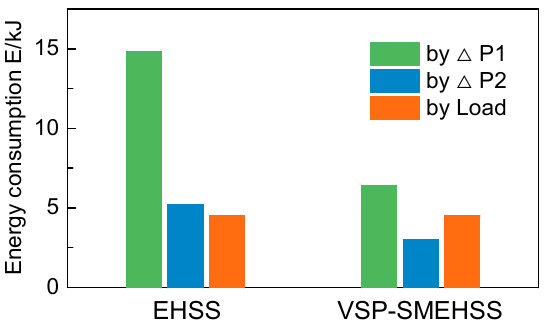
Figure 18. Energy consumptions of the EHSS and the VSP-SMEHSS due to ∆ P 1 , ∆ P 2 , and the load.